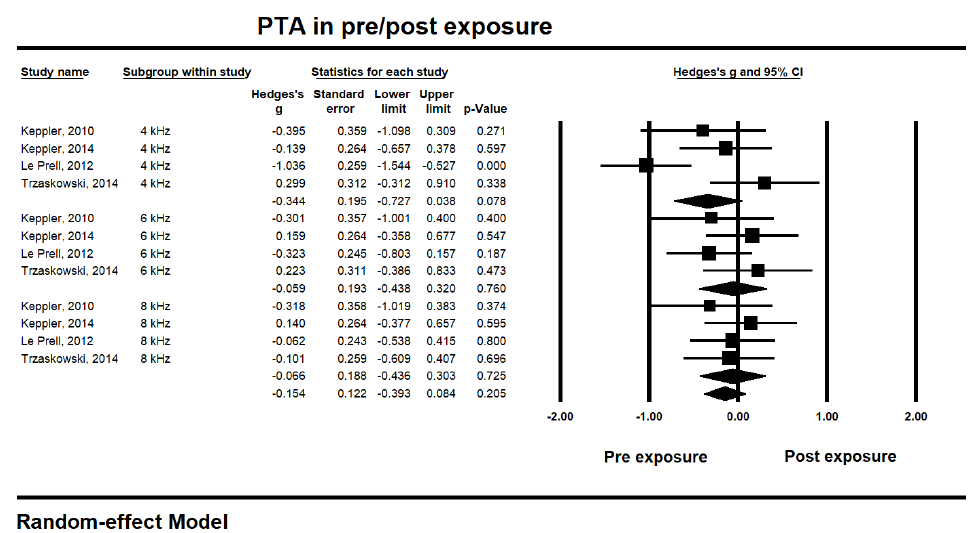
Figure 2. Short-term hearing changes for the pure tone audiometry (PTA) thresholds at 4, 6, and 8 kHz within 24-h after music exposure.